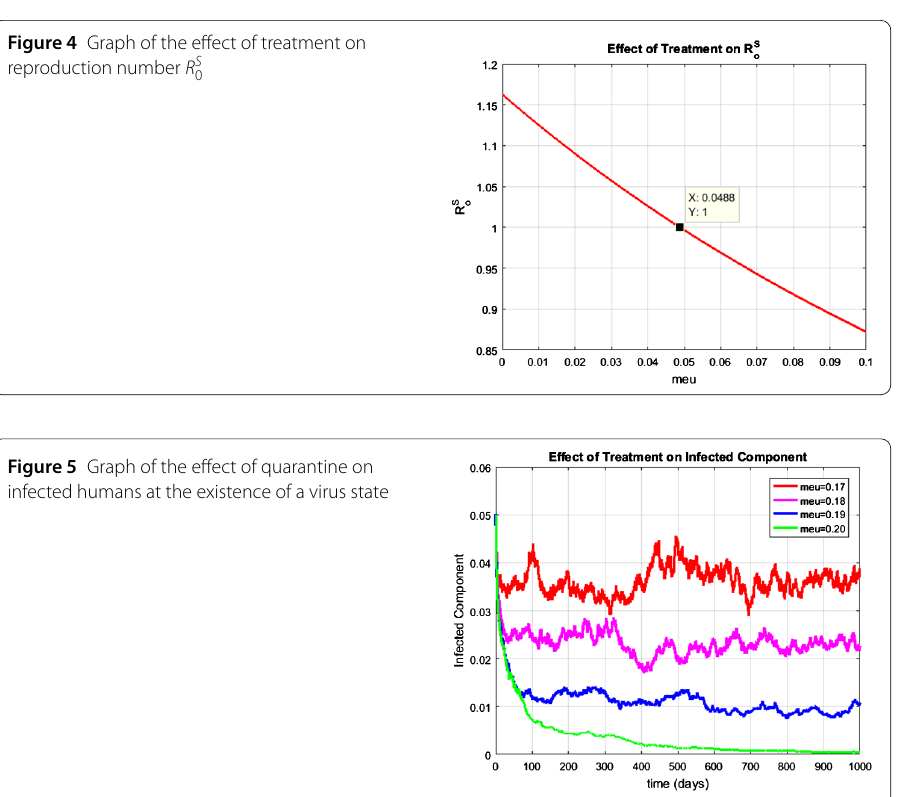
Figure 4 Graph of the effect of treatment on reproduction number R S